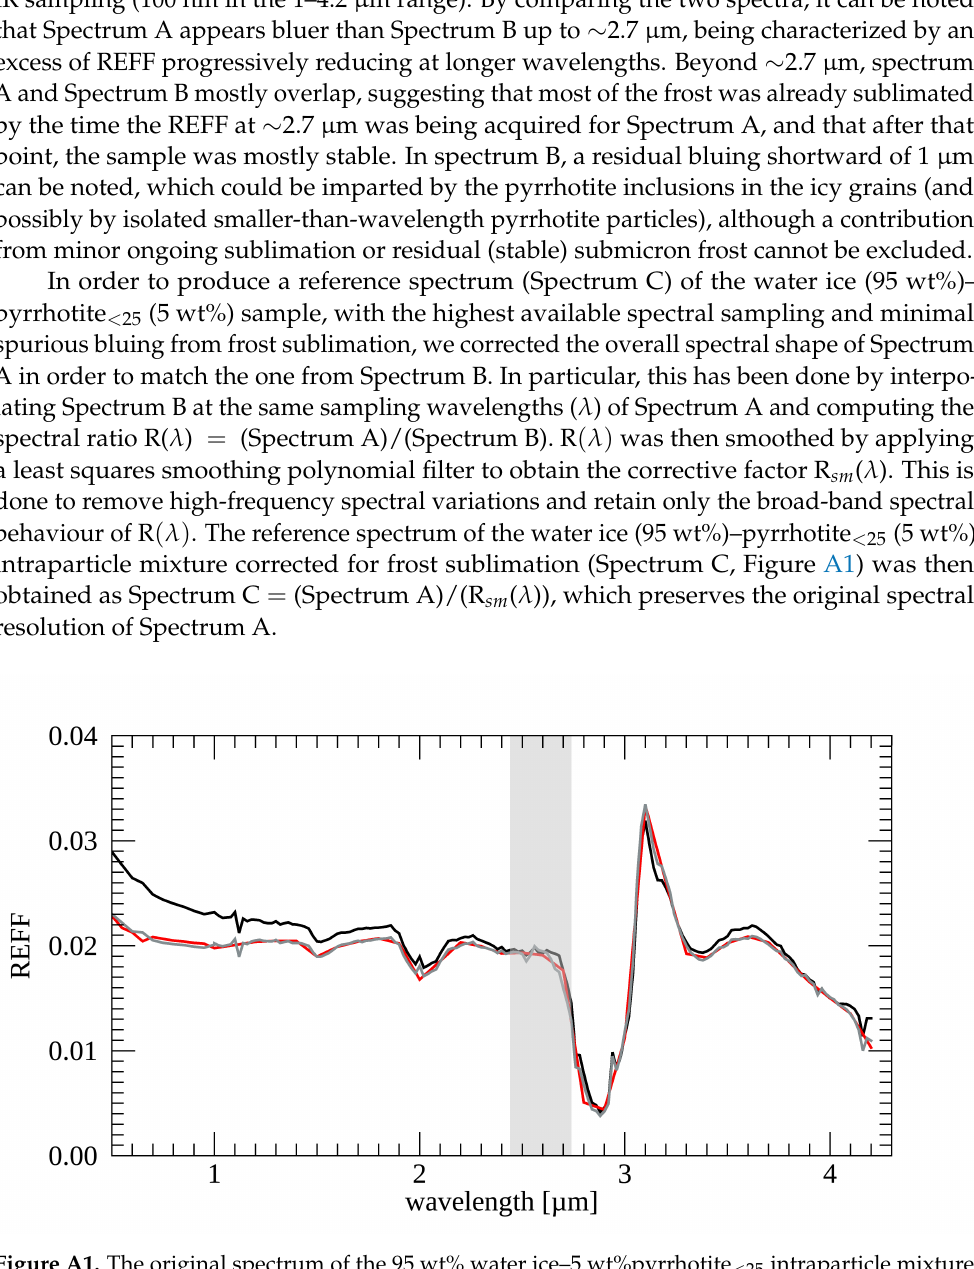
Figure A1. The original spectrum of the 95 wt% water ice–5 wt%pyrrhotite < 25 intraparticle mixture (Spectrum A, black) is compared to Spectrum B (red) and to the mixture reference spectrum after cor- rection for frost sublimation (Spectrum C, grey). The light grey bands indicate a spectral region where possible residual water vapour contamination in the optical path may affect the resulting